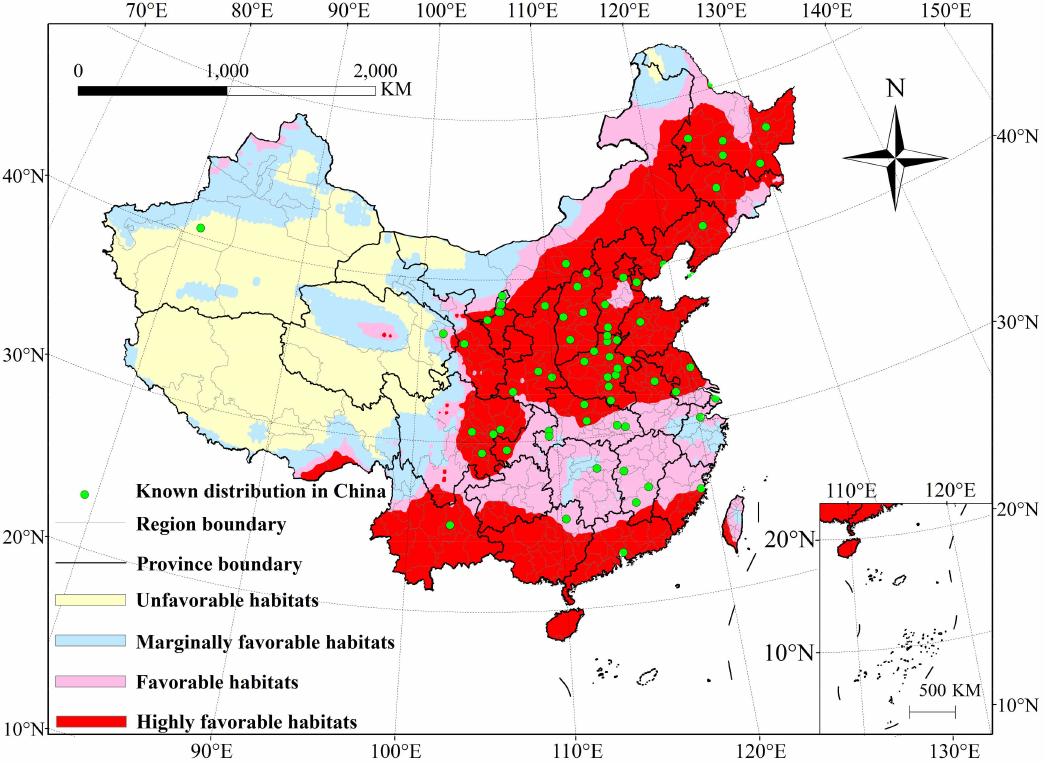
Figure 1. Potential distribution of P. interpunctella in China under historical climate conditions